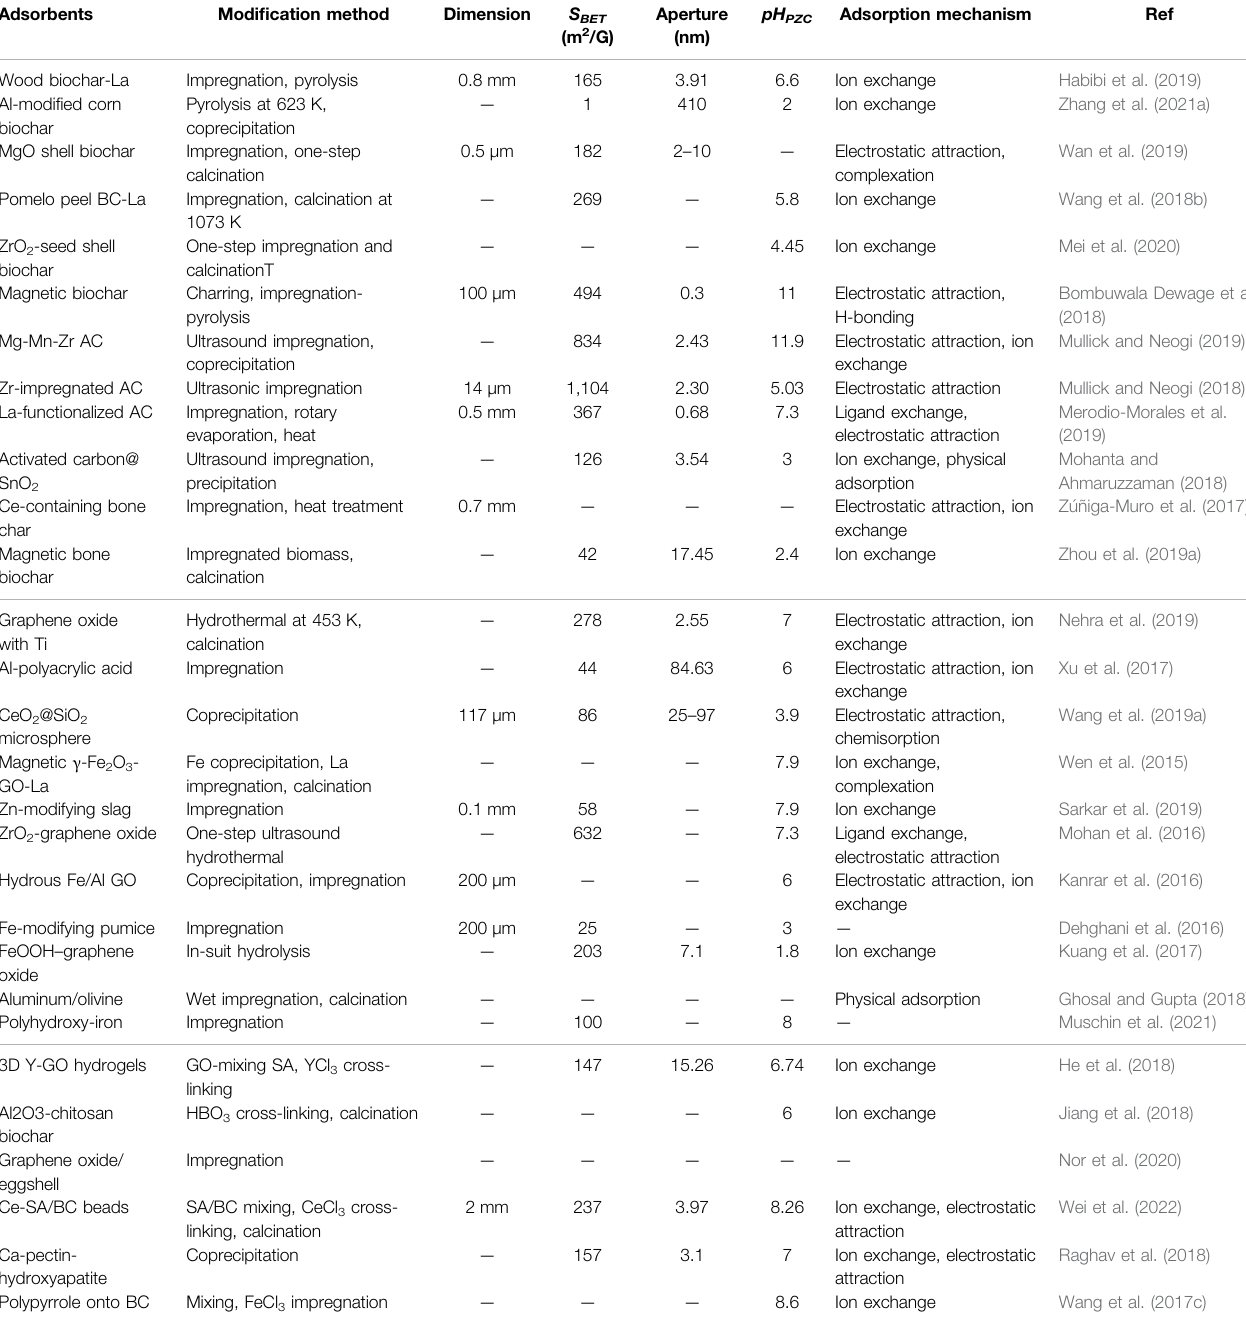
TABLE 5 | Summary of modi fi cation methods, characteristics, and adsorption mechanisms of metal-modi fi ed carbon and other